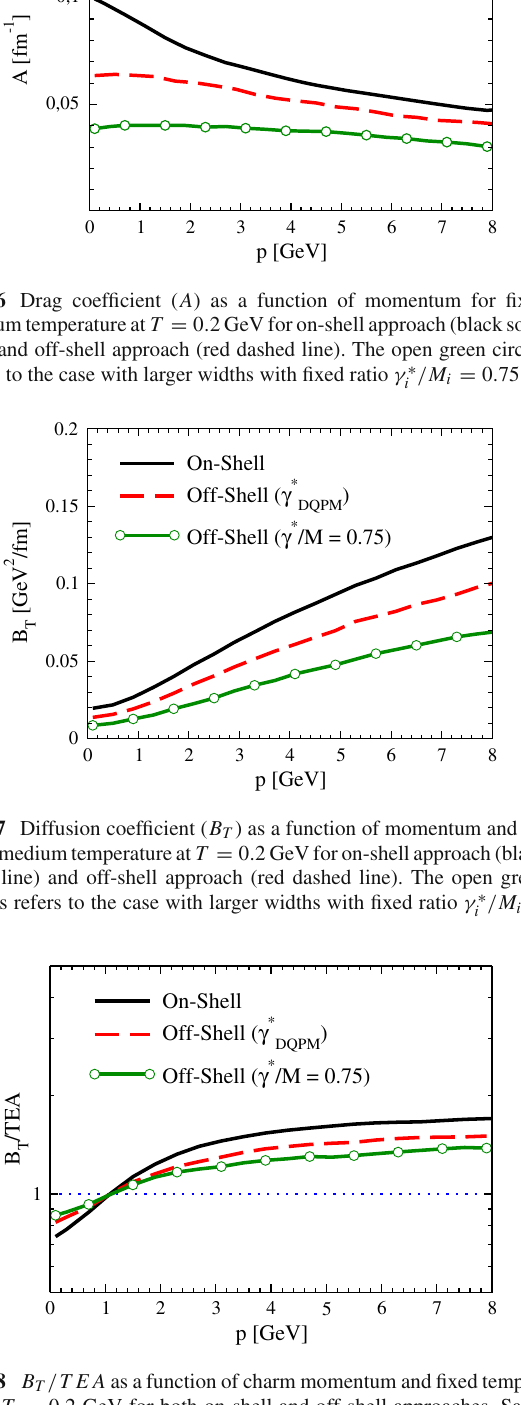
Fig. 8 B T / T E A as a function of charm momentum and fixed temper- ature T = 0 . 2 GeV for both on-shell and off-shell approaches. Same legend as in Fig.